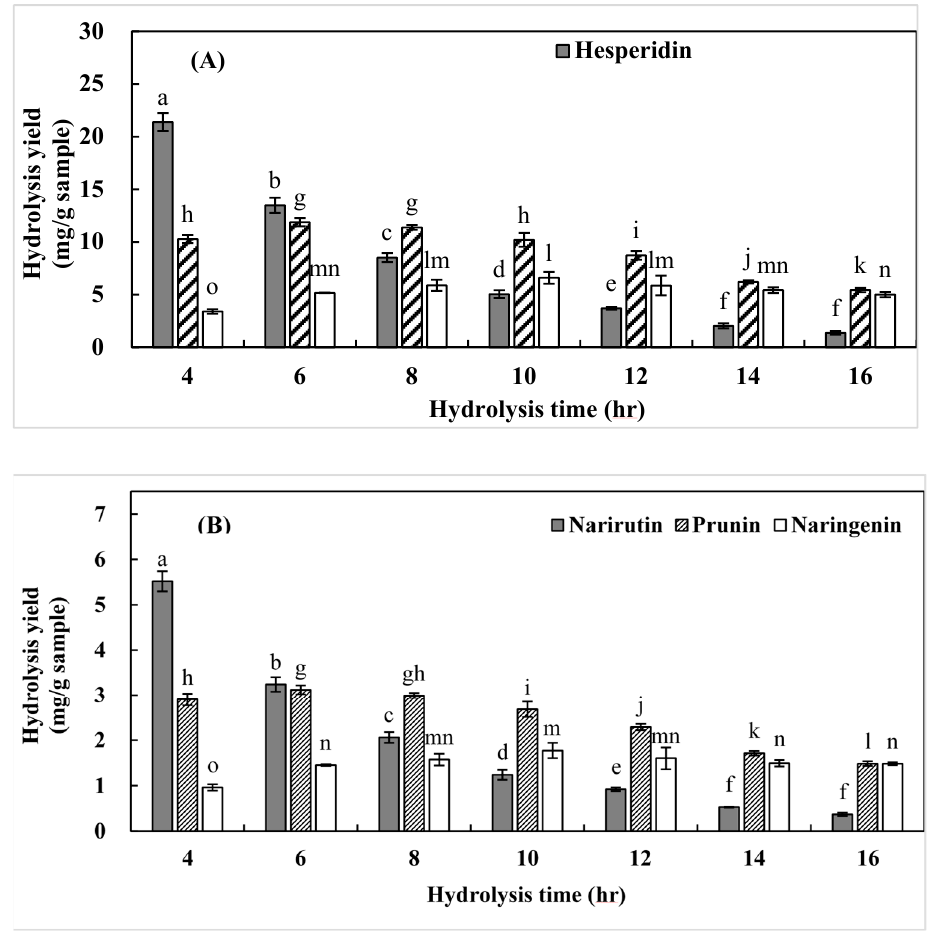
Figure 2. Hydrolysis yields of ( A ) hesperetin-7- O -glucoside and hesperetin and ( B ) prunin and naringenin obtained from immature Citrus unshiu pomace under different hydrolysis durations, with a temperature of 120 °C, and 10% citric acid. Bars accompanied by different letters (a–o) indicate significant differences ( n = 3) ( p < 0.05, Duncan’s test).